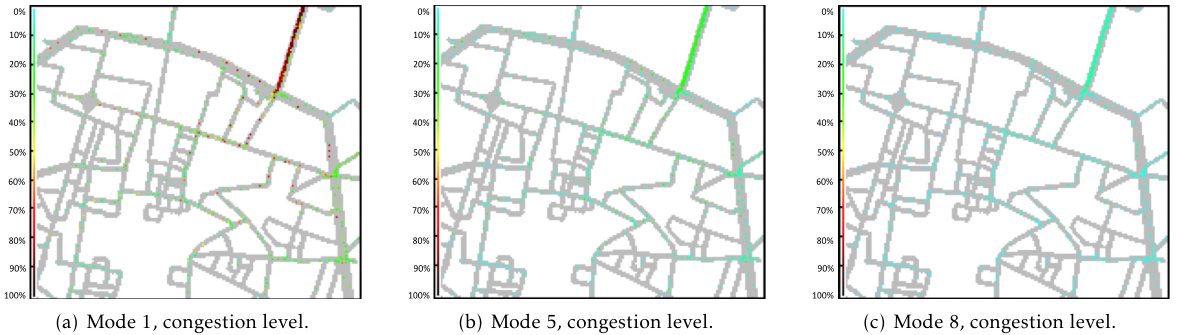
Figure 5. Congested traffic, beacons of 200 bytes. Beacon delivery rate as a function of the position of receiving OBUs.